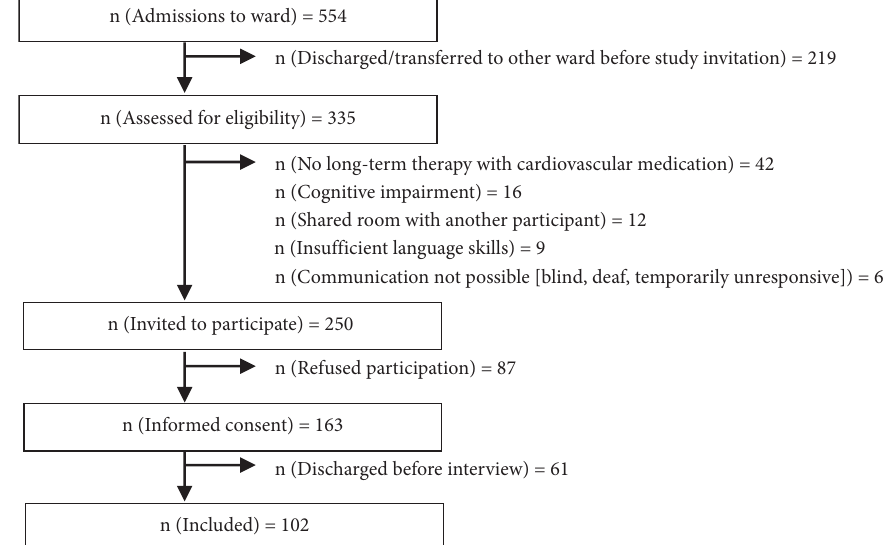
Figure 1: Flow chart of the participating